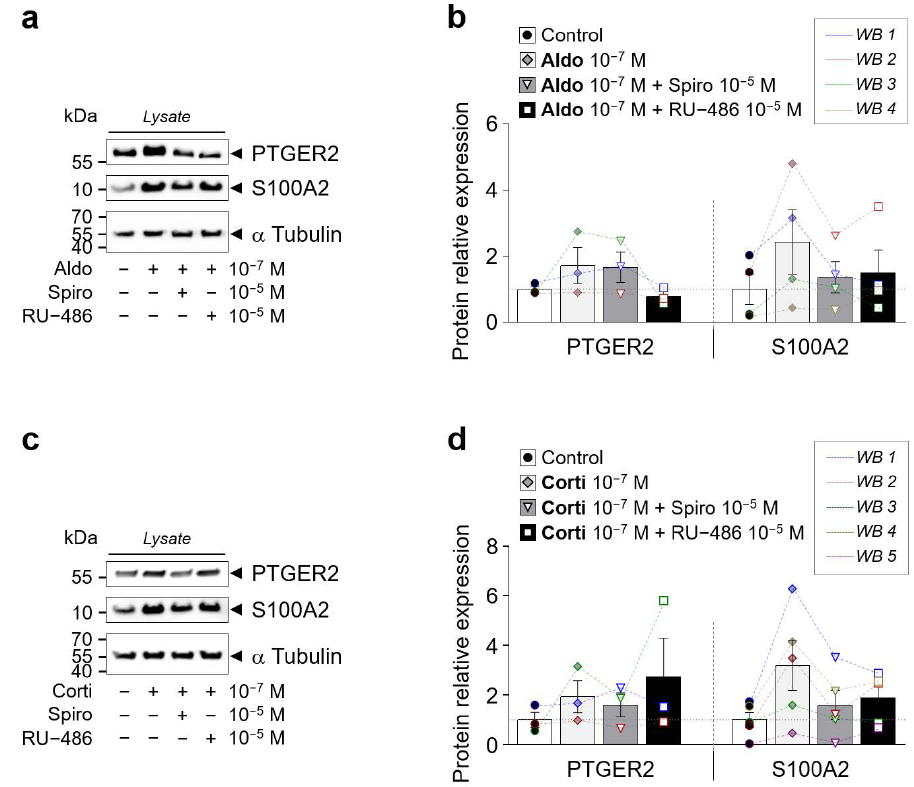
Figure 7. Western blot of PTGER2 and S100A2 in iRPE cells. ( a) and ( b ) Western blot of PTGER2 and S100A2 protein expres- sion in iRPE cells following 24 h treatment of aldosterone (aldo) 10 − 7 M ( a ) or cortisol (corti) 10 − 7 M ( b ) ± spironolactone (spiro) 10 − 5 M or RU-486 10 − 5 M. α -Tubulin is used as loading control. Arrows indicate the expected size of the 55 kDa PTGER2, 15 kDa S100A2 and 50 kDa α -Tubulin proteins. ( c , d ) Bar graphs represent densitometric quantification of PTGER2 ( n = 3) and S100A2 ( n = 4–5) protein expression relative to α -Tubulin levels in protein lysate (panel a and b ). Values are means ± SEM. S100A2, S100 calcium-binding protein A2; PTGER2, prostaglandin E receptor